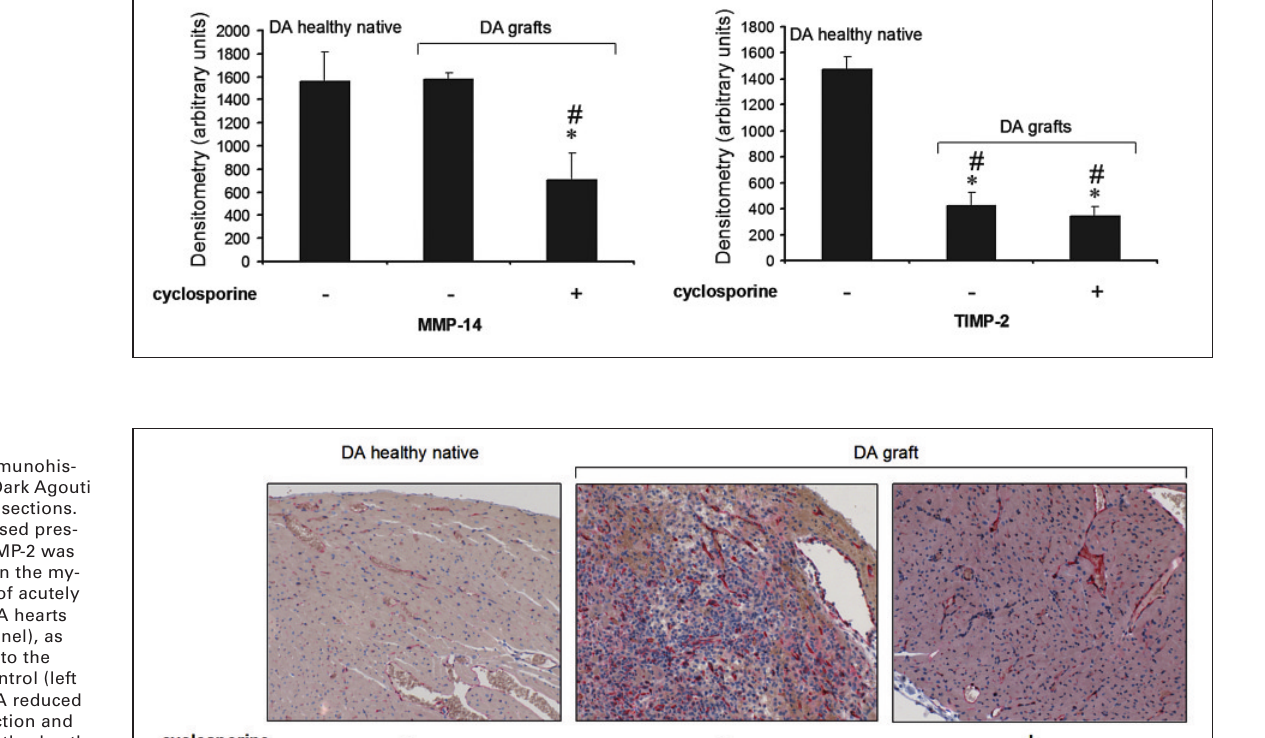
Rat heart MMP protein expression. Western blot and densitometry analy- ses of MMP-2 (a), MMP-9 (b), MMP-14 (c),TIMP-2 (d) in rat hearts.Two represen- tative samples for each group are depicted. *p <0.05 compared to the DA healthy native hearts, # p <0.05 compared to the DA grafts CsA- treated; n = 4 per group.